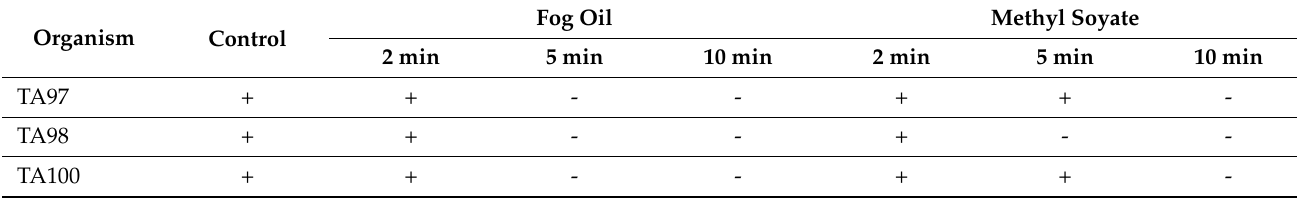
Table 3. Exposure results of plates covered with Kimwipe ® .